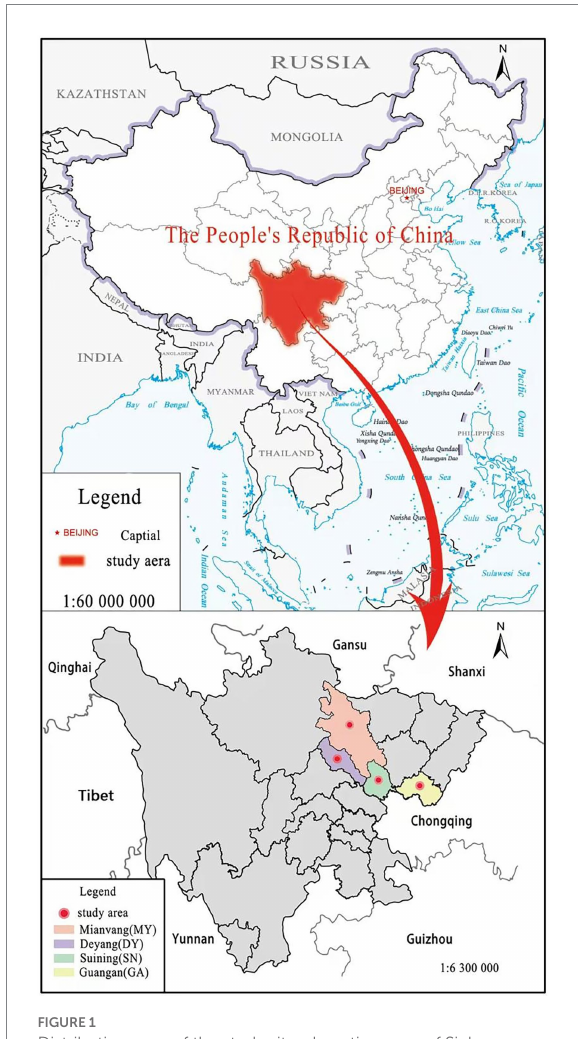
FIGURE 1 Distribution map of the study sites. Location map of Sichuan province and the four study sites in Sichuan province: Mianyang (MY), Deyang (DY), Suining (SN), Guangan (GA).